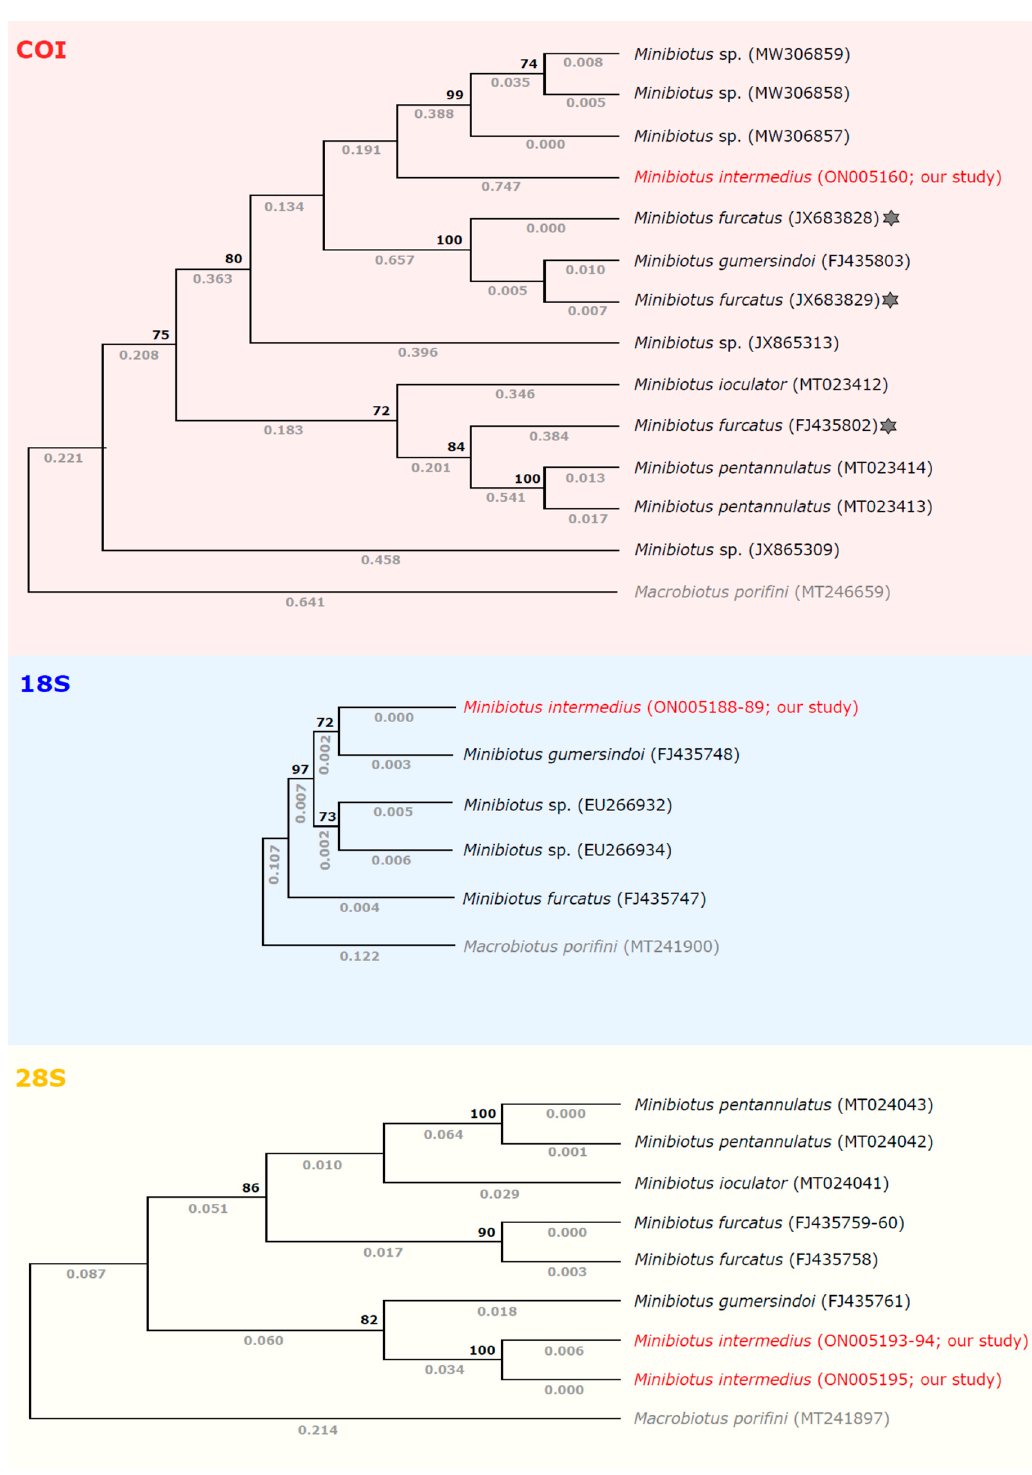
Figure 6. The phylogenetic position (maximum likelihood analyses) of M. intermedius (marked in red) generated as follows: COI datasets under the HKY + G model, 18S rRNA datasets under the K2 model, and 28S rRNA datasets under the K2 + G model. The tree with the highest log likelihood is shown. Supporting bootstrap values are given above the branches (nodes with bootstrap <70 were collapsed) and the number of substitution events per site is given below the branches. The GenBank accession numbers of all the sequences applied are given in SM02. Species with a questionable position on the phylogenetic tree were marked in gray stars.